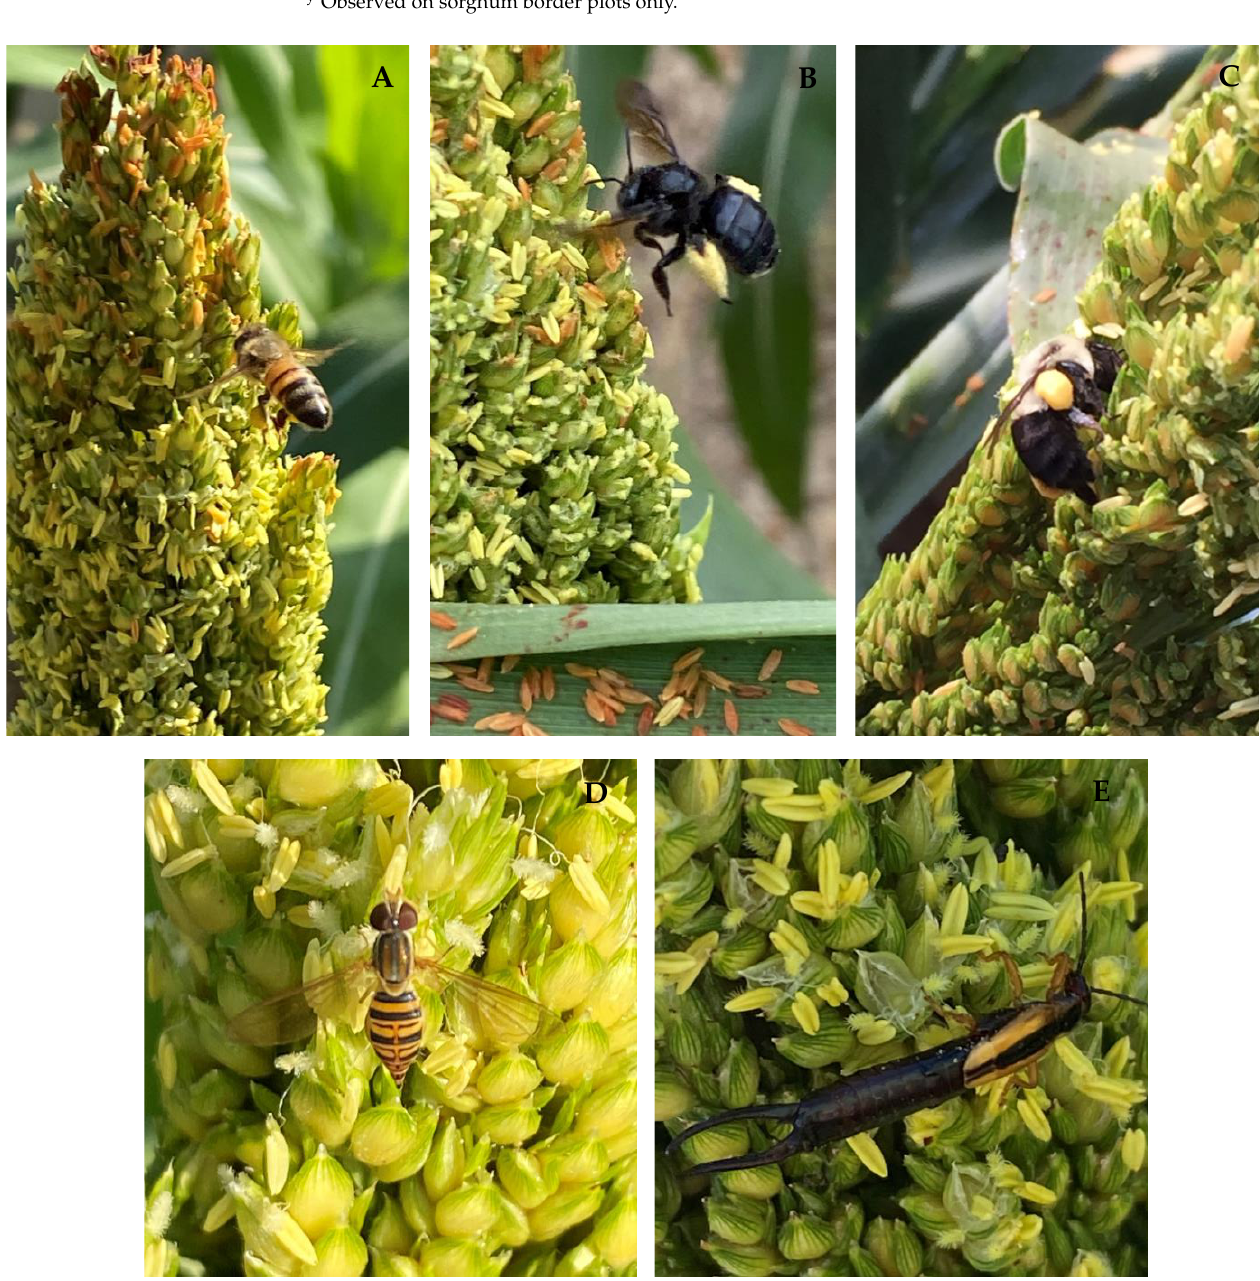
Figure 2. Top panel, ( A ) honeybee ( Apis mellifera ), ( B ) carpenter bee ( Xylocopa micans ), and ( C ) bumble- bee ( Bombus sp.) collecting sorghum ( Sorghum bicolor ) pollen. Bottom panel, ( D ) a hoverfly ( Toxomerus politus ) and ( E ) earwig ( Doru taeniatum ) consuming sorghum